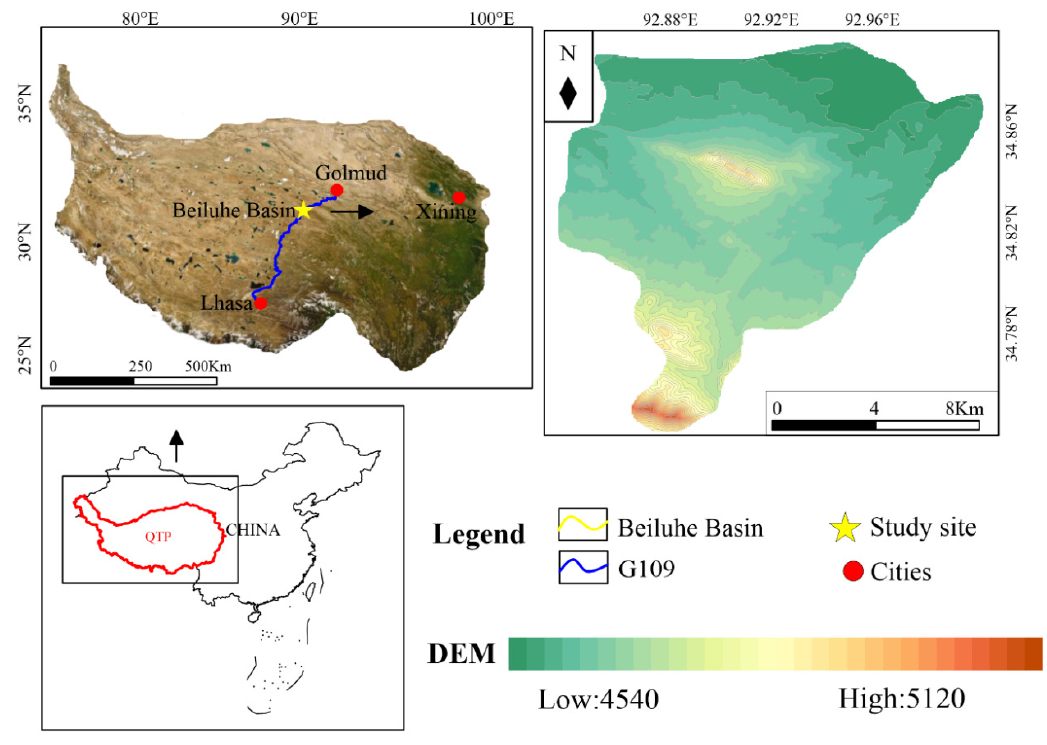
Figure 2. Location of the study area.